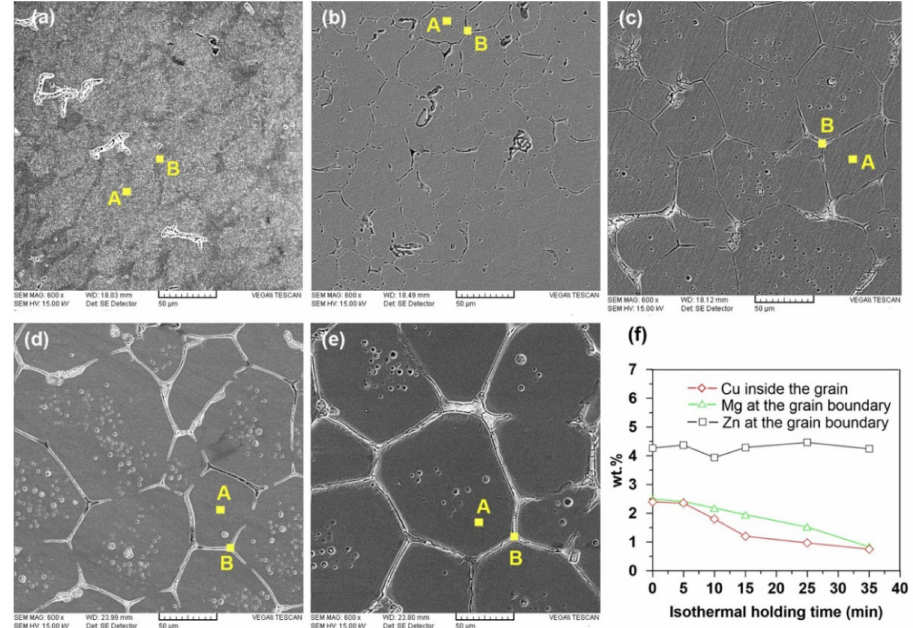
Figure 9. SEM images of sample compressed 20% , heat treated at 600 ˝ C for ( a ) 5 min; ( b ) 10 min; ( c ) 15 min; ( d ) 25 min; ( e ) 35 min and then water quenched; ( f ) EDS analysis results of the grain centers (A point) and grain boundaries (B point).